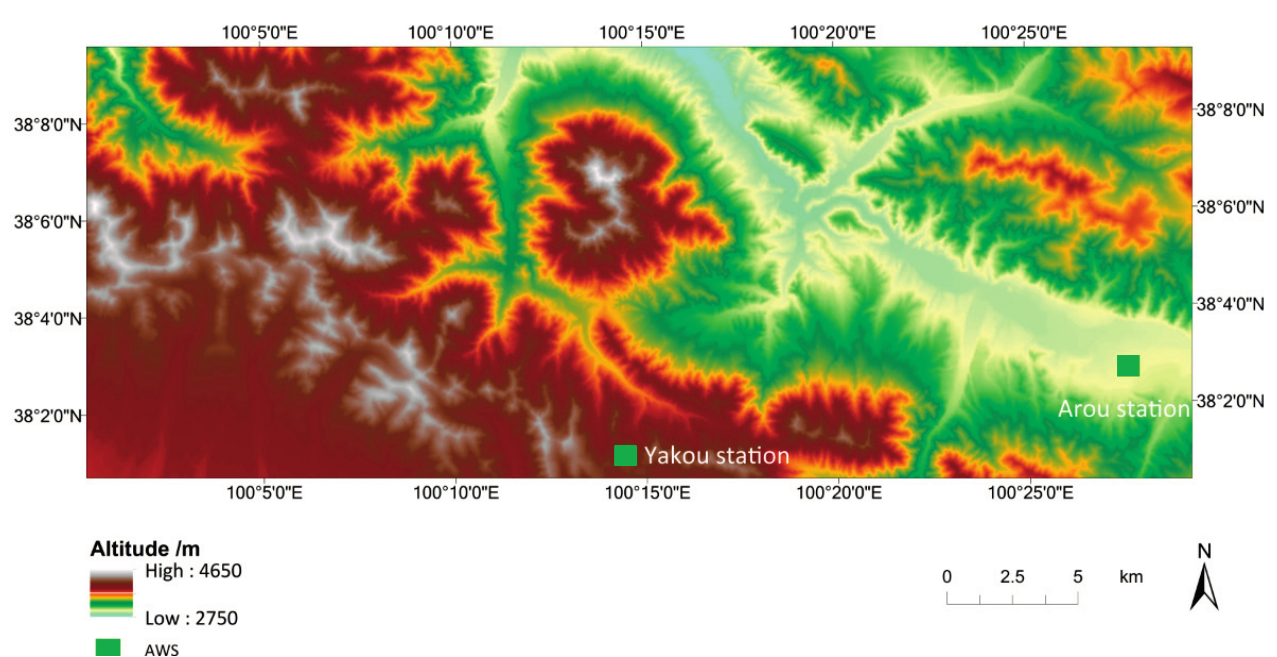
Figure 2. Study region DEM and AWS locations in the Babaohe basin of the Qilian mountainous region in China. Two automatic weather stations are located in the study